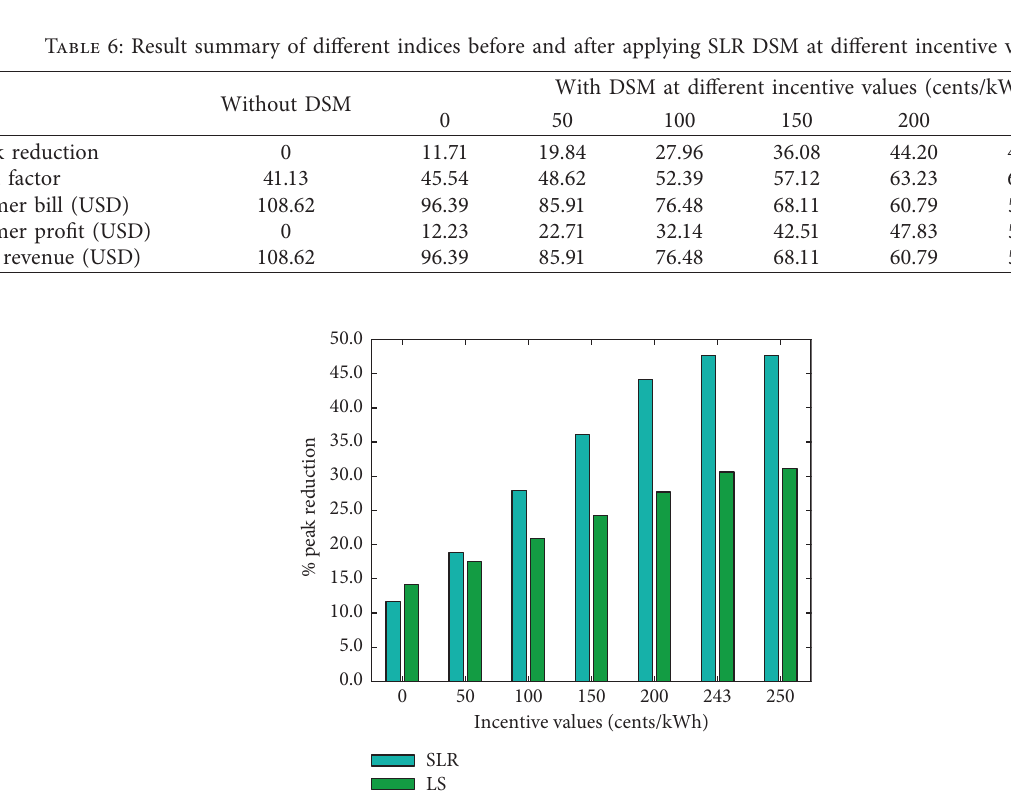
Figure 11: Percentage peak reduction after implementation of LS and SLR DSM programs.